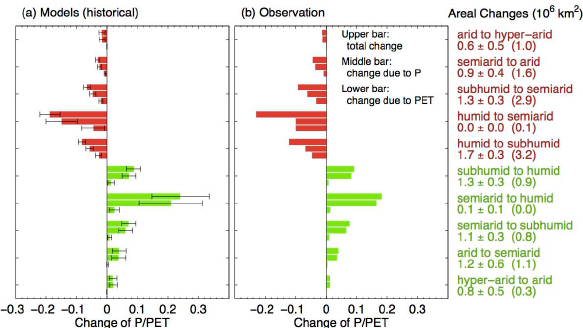
Fig. 10. Changes in P /PET (upper bar) and contributions of precip- itation (middle bar) and PET (lower bar) to P /PET changes from 1948–1962 to 1991–2005, averaged over changed areas of drylands from (a) historical simulations and (b) observations. Error bars give the one standard deviation of the 27 models. The numbers on the right and those in parentheses show area changes from models and observations,